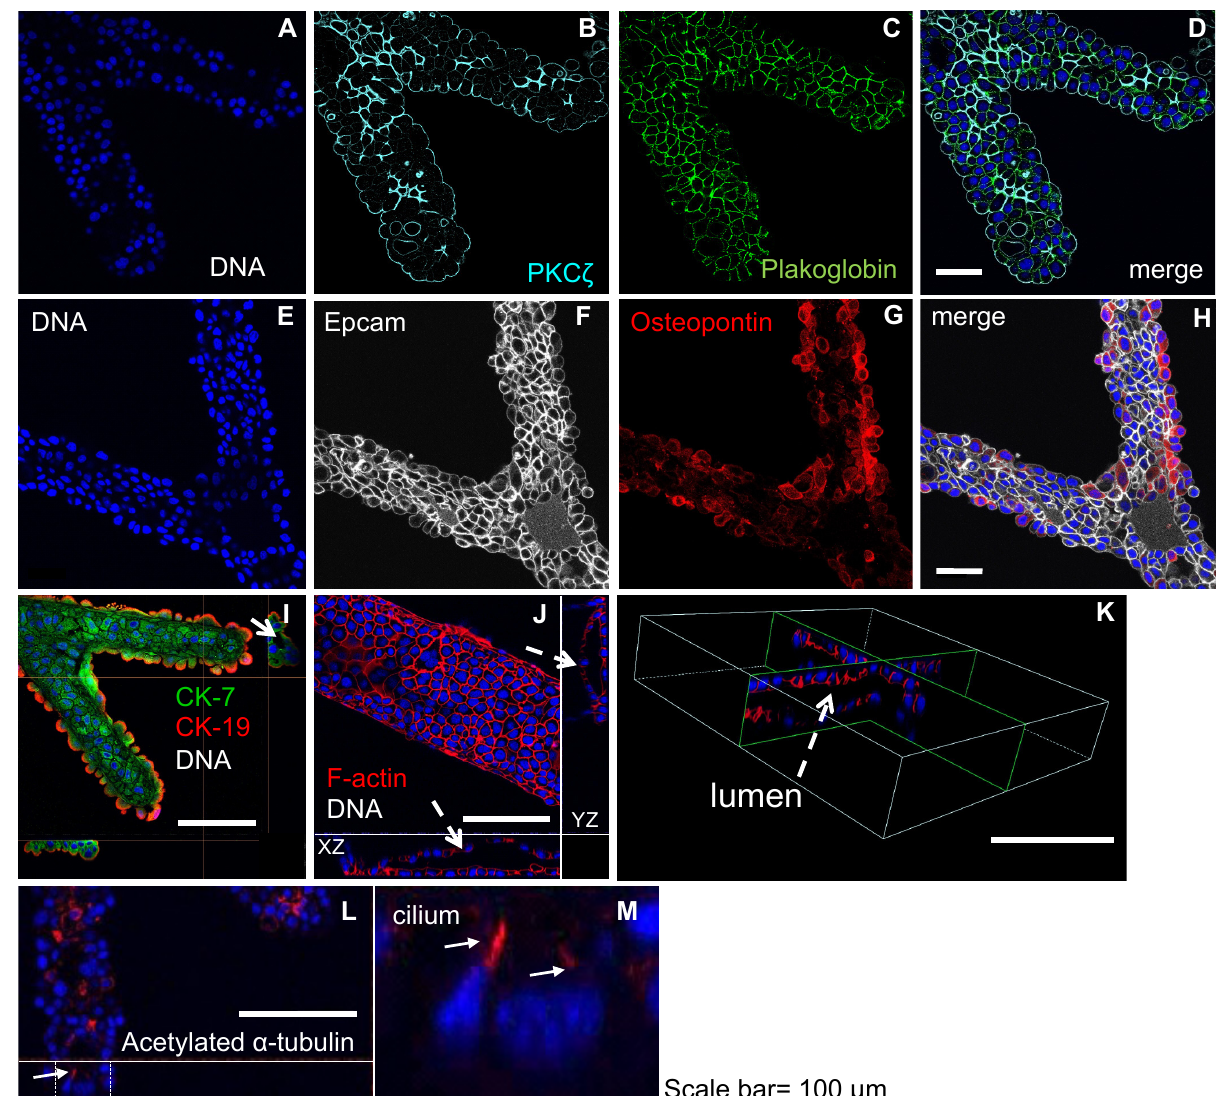
Figure 4. Tubular networks are polarized and retain the biliary phenotype. Confocal microscopy of immunofluorescence images of tubular networks at day 10 post-HUVEC seeding in NRCs:HUVEC 10:1 co-culture showing a single focal plane of ( A ) nuclei, ( B ) PKC ζ , ( C ) plakoglobin, ( D ) merge, ( E ) nuclei, ( F ) Epcam, ( G ) osteopontin, and ( H ) merge. Orthogonal views of Z-stacks of ( I ) CK7-CK19-tubes (white arrow pointing at a lumen on the YZ plane), ( J ) F-actin 3D reconstruction showing the XZ and YZ orthogonal views of the inside of an F-actin labeled tree branch, ( K ) 3D orthogonal views of a single luminal structure (pointed as “lumen”) with nuclei staining and F-actin expressed at the apical face of cells, and ( L ) and ( M ) inset ortho views showing acetylated α -tubulin revealing the presence of primary cilia, scale bar = 100 µm.